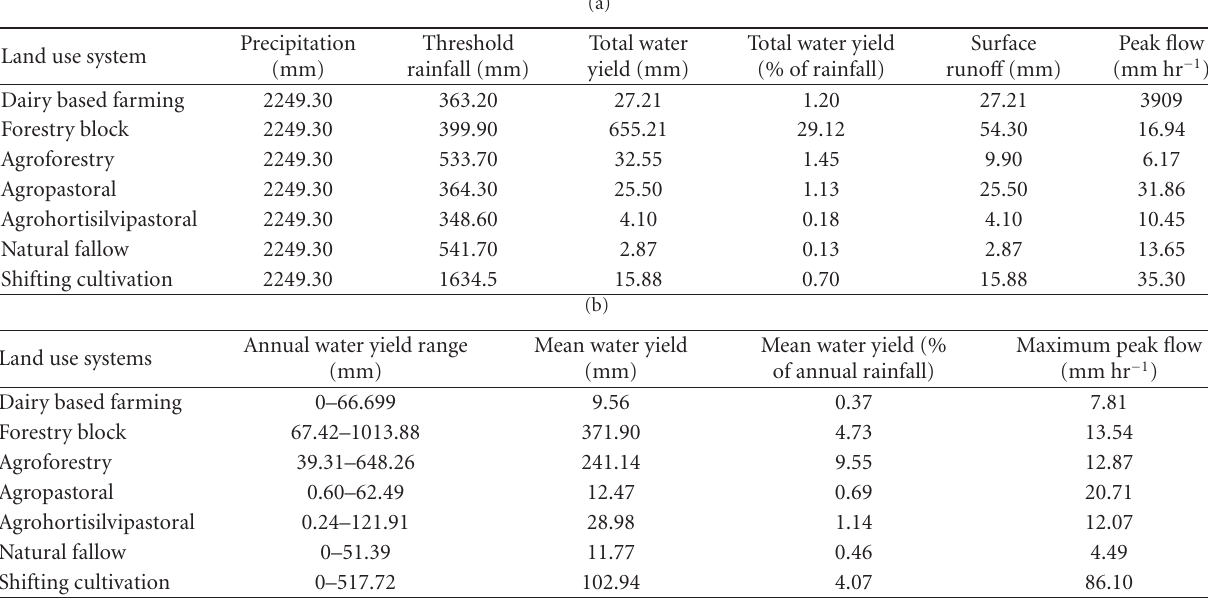
Table 6: (a) Pretreatment (year) precipitation, storm flow, peak flow rate in di ff erent land use systems. (b) posttreatment water yield, base flow, and peak flow in di ff erent land use systems (average of nine years).